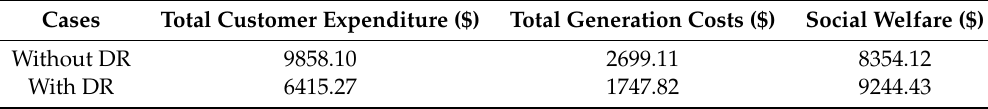
Table 3. Comparison of market performance with and without